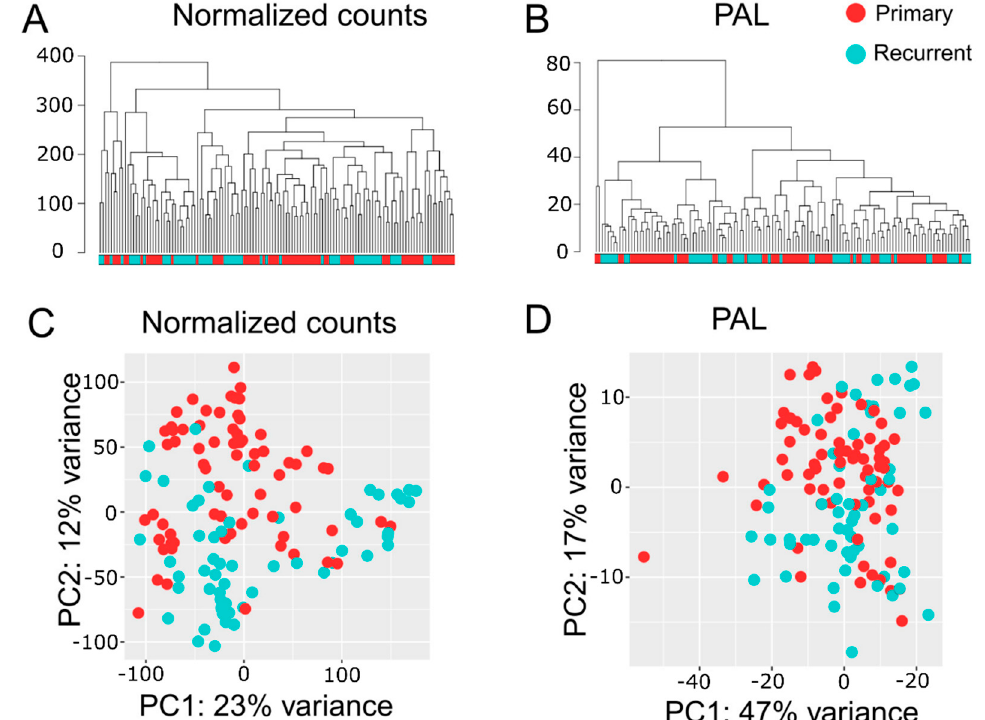
Figure 2. Hierarchical clustering dendrogram of RNA-seq profiles for GB tissue samples. Normalized gene expression ( A ) and pathway activation level (PAL, B ) data were used to calculate Euclidian distance between the samples. Principal component (PC) analysis of RNA-seq profiles for GB tissue samples using normalized gene expression ( C ) or PAL ( D ) data. Color marker in PCA plots indicates tissue type. Values aligned with axis show proportion of variance in percent for principal components 1 and 2, respectively. Color marker indicates tissue type (ndGB or recGB).